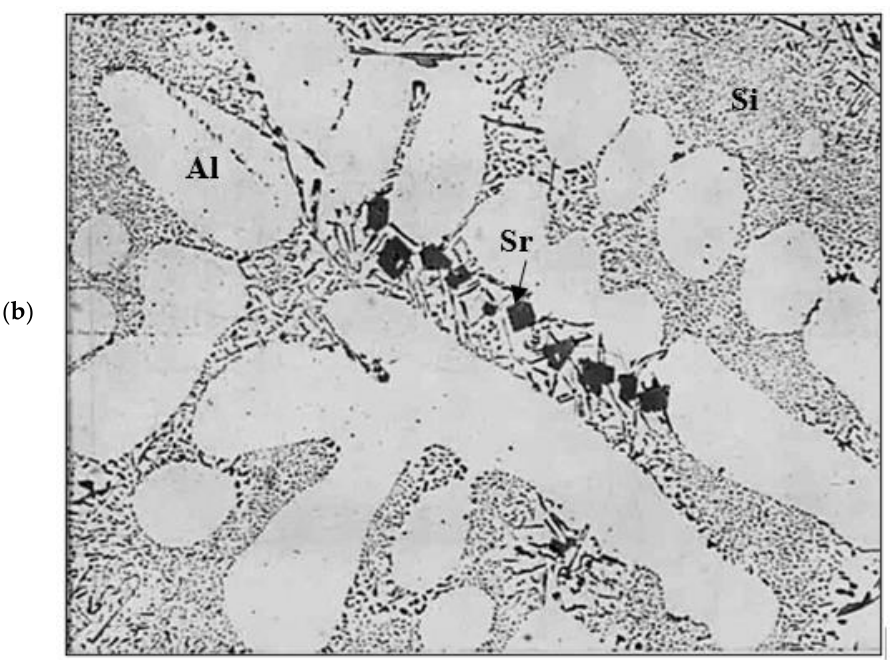
Figure 7. ( a ) Schematic diagram showing rejection of solute atoms in front of a growing α -Al dendrite in B (Sr-modified 319) alloy and Bi-containing B alloy. ( b ) An example of the rejection of Sr and Si in front of developed Al network.